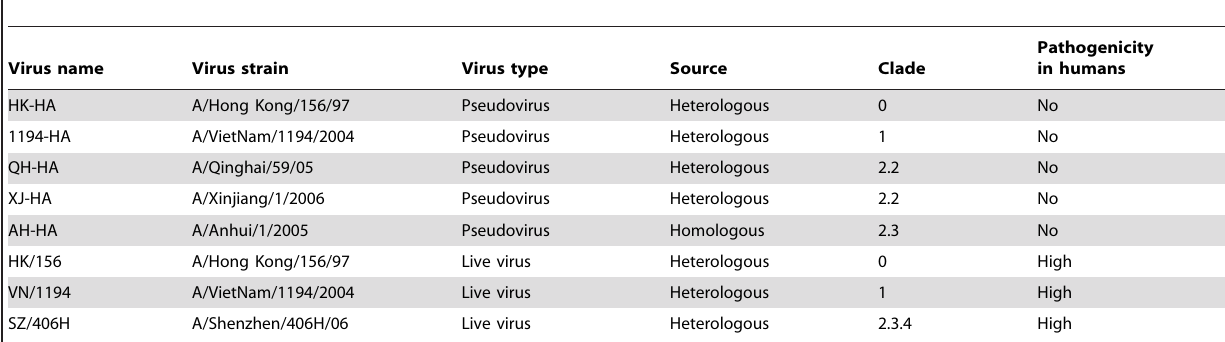
Table 1. Summary of H5N1 pseudovirus and live virus strains used in the study.